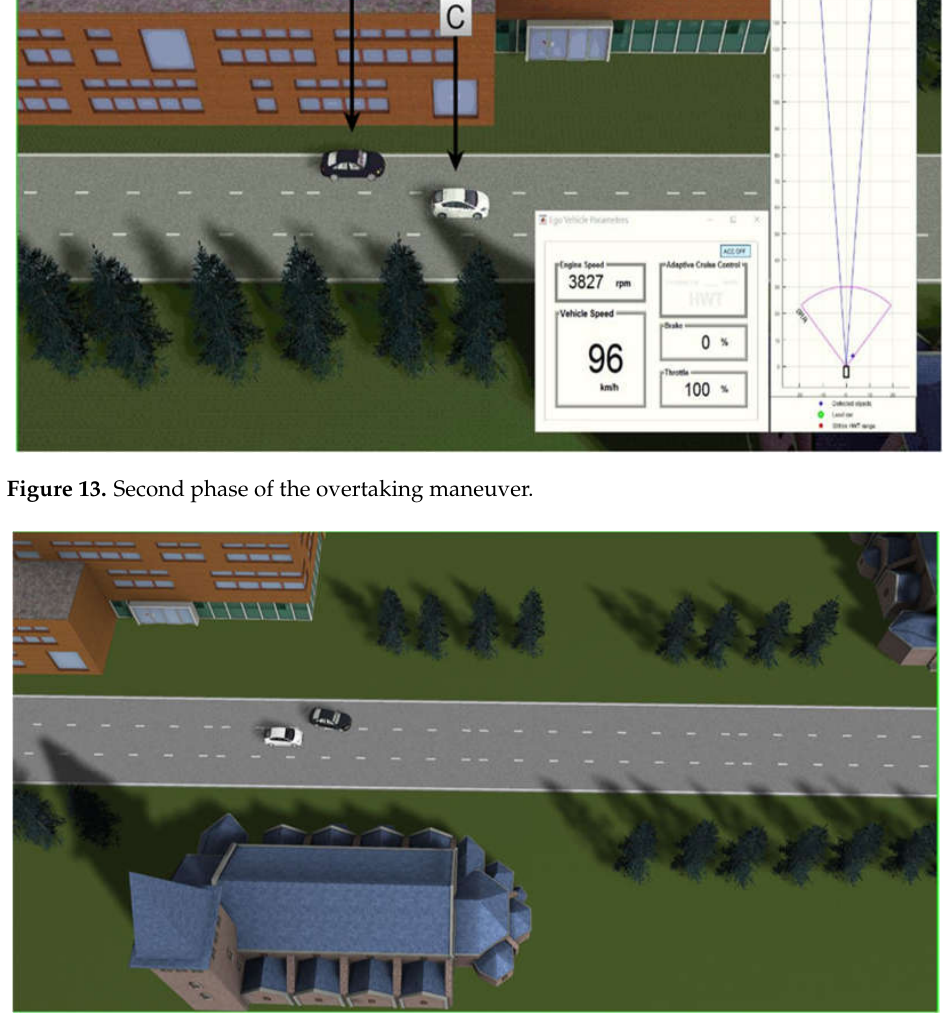
Figure 14. Vehicle A changing phase, from left lane to center lane.